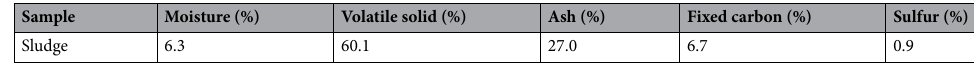
Table 2. Proximate analysis of the beverage wastewater treatment sludge.